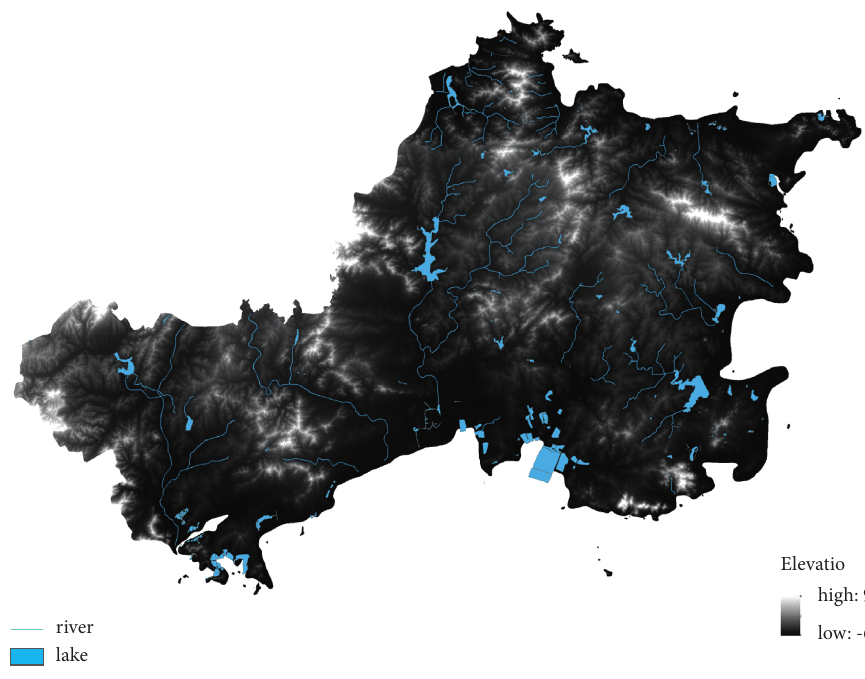
Figure 5: Current river network in